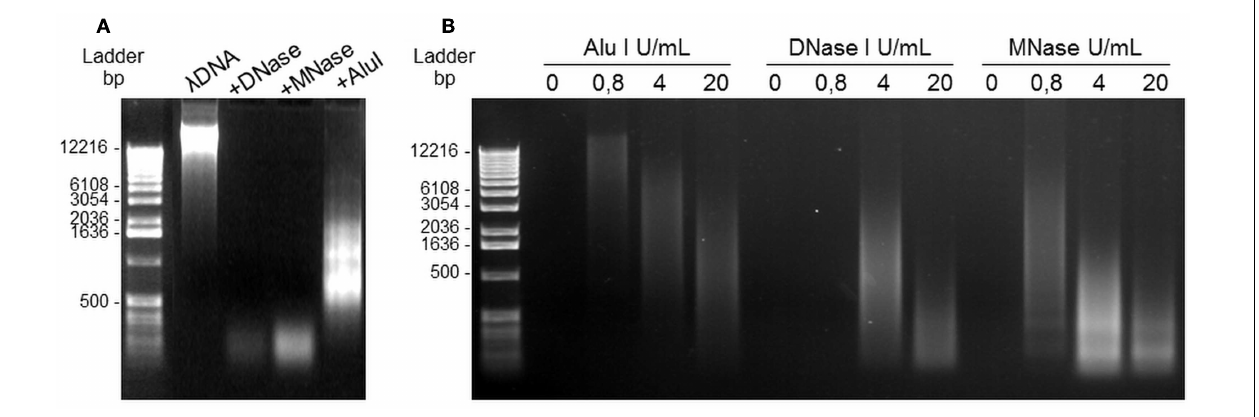
stimulation of PMN. Incubation with the restriction enzymes lasted 20min at 37°C. DNA migration took place in 0.8% agarose gel containing ethidium